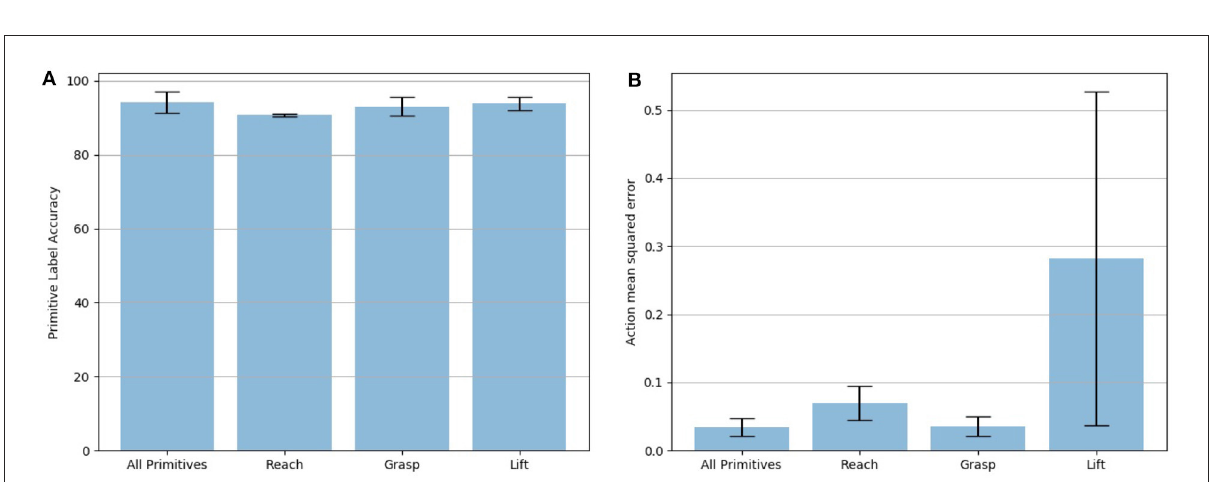
FIGURE6 Accuracy of PICO to correctly identify a primitive’s label on the validation set (20 randomly selected trajectories). (A) The leftmost bar shows performance when all primitives are in the library, successive bars denote accuracy when the reach , grasp , and lift primitives are dropped out and learned from a randomly generated “gap” primitive. Error bars represent the standard deviation across five validation trials. (B) Mean squared error between the ground truth action and the learned model’s estimate averaged across 20 randomly selected test trajectories five